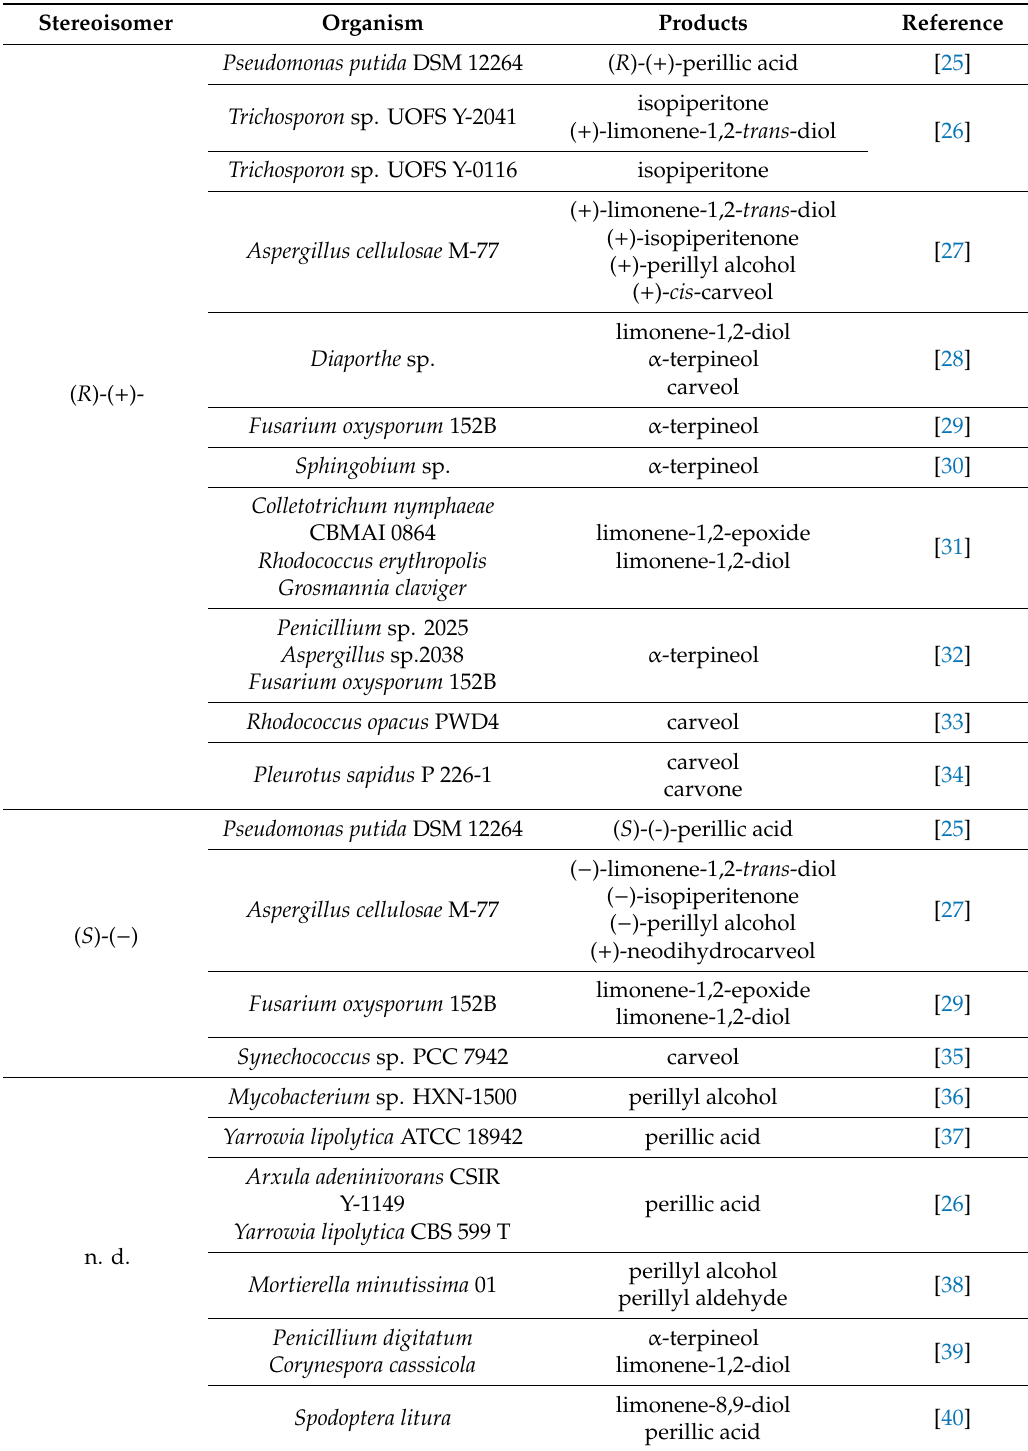
Table 1. Biotransformation of